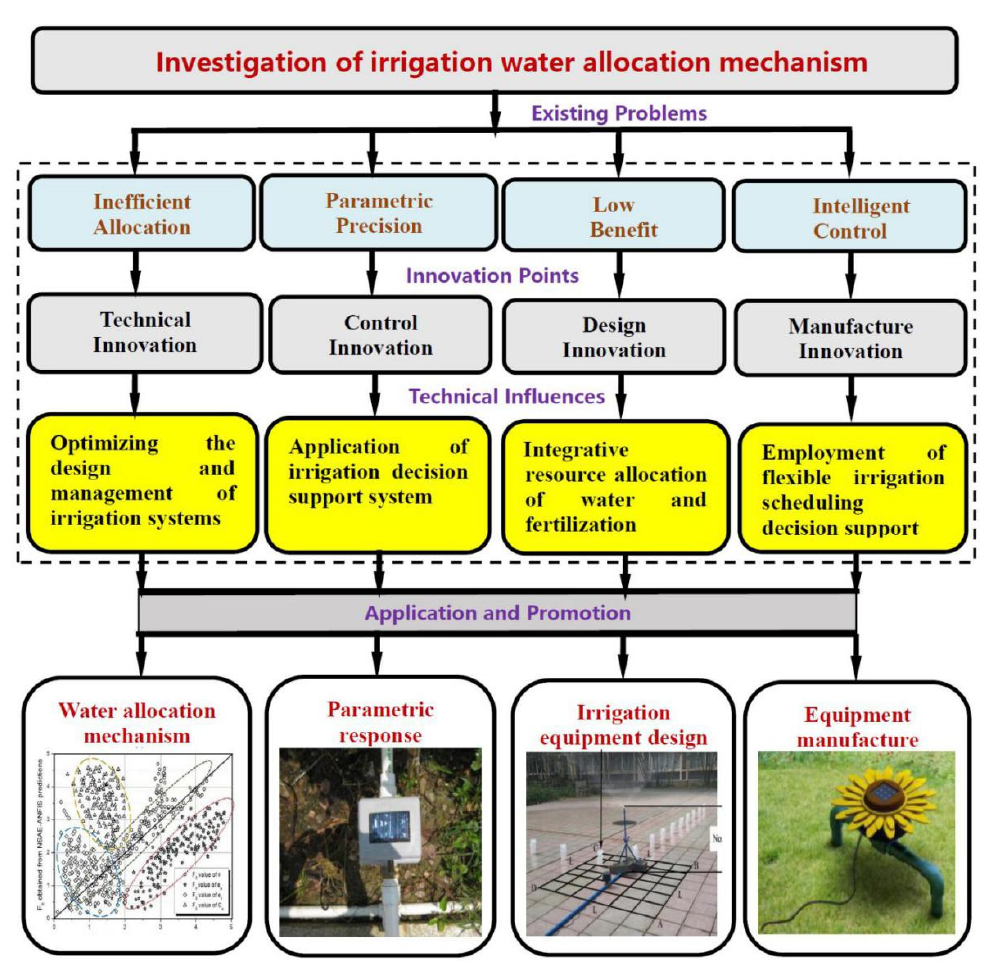
Figure 1. Research progress and equipment development in the water allocation mechanism.